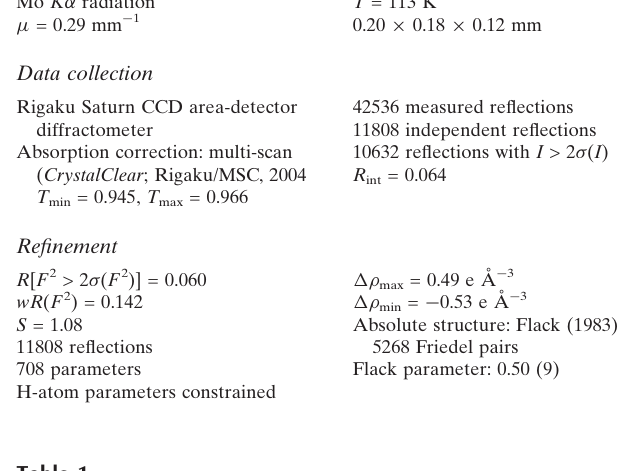
Hydrogen-bond geometry (A˚ , (cid:4)